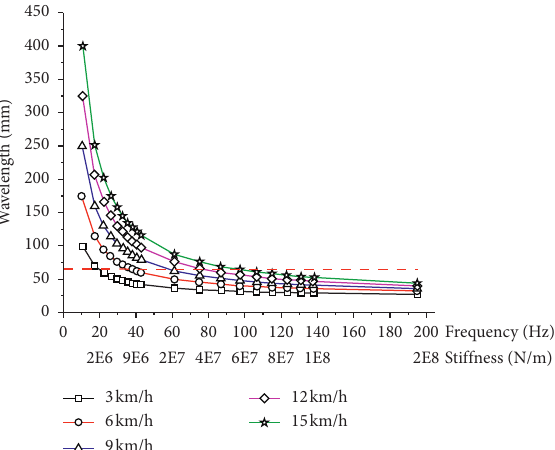
Figure 14: Length of grinding cracks under different stiffness levels of deflection cylinder and different grinding